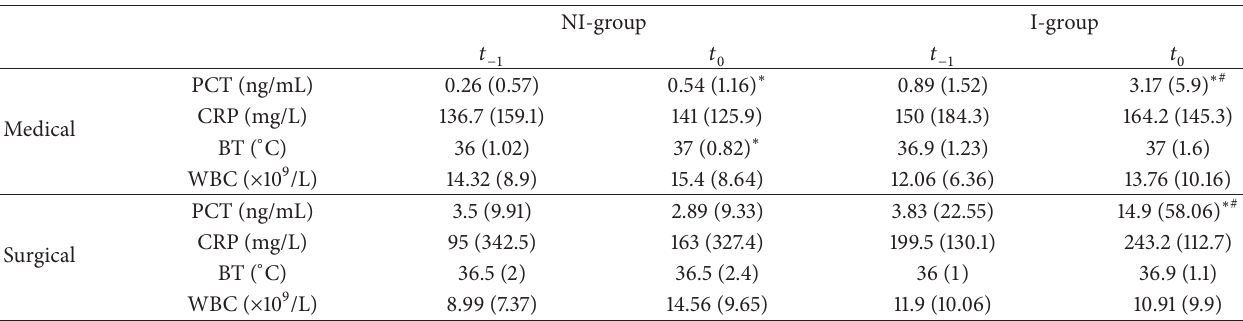
Table 3: PCT, CRP, body temperature, and white blood cell count in medical and surgical patients with and without